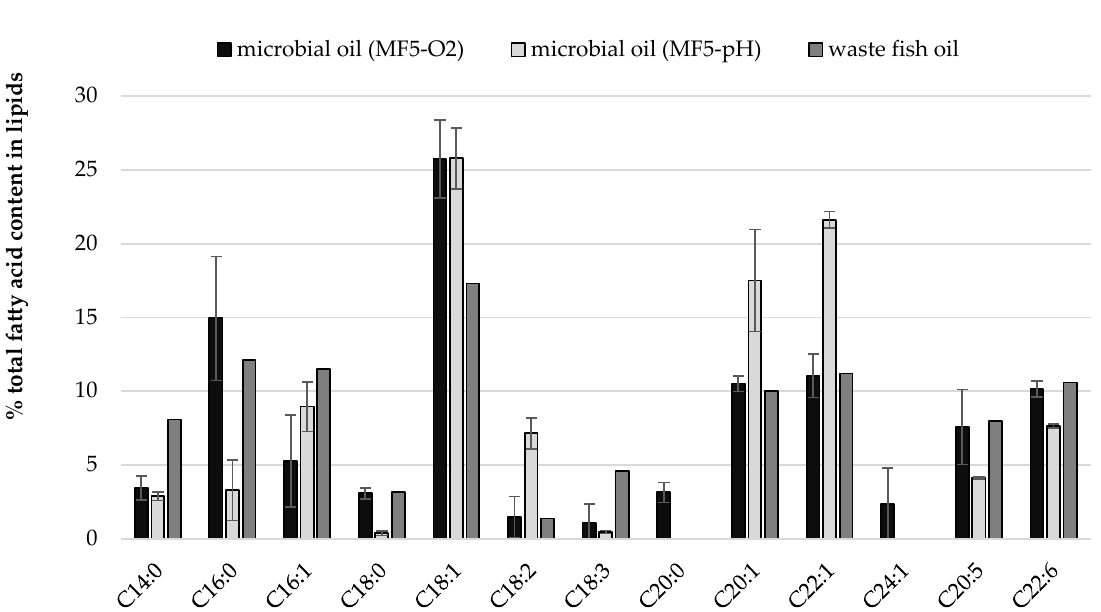
Foods 2021 , 10 , 436 Figure 2. Comparison of fatty acid content in waste fish oil (carbon source in growth medium) and cellular lipids from yeast cell grown in MF5 medium in cultures where aeration (MF5-O 2 ) and pH (MF5-pH) parameters were modified.